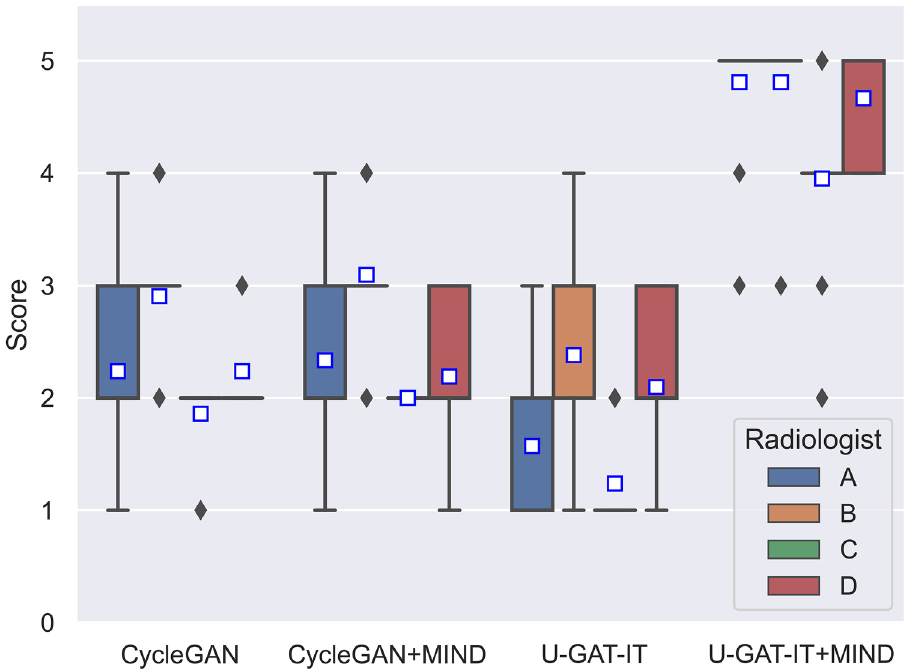
Figure 11. Boxplot of visual evaluation scores (note: small squares indicate the median score). As can be seen, the U-GAT-IT + MIND approach demonstrates higher scores by all Drs.